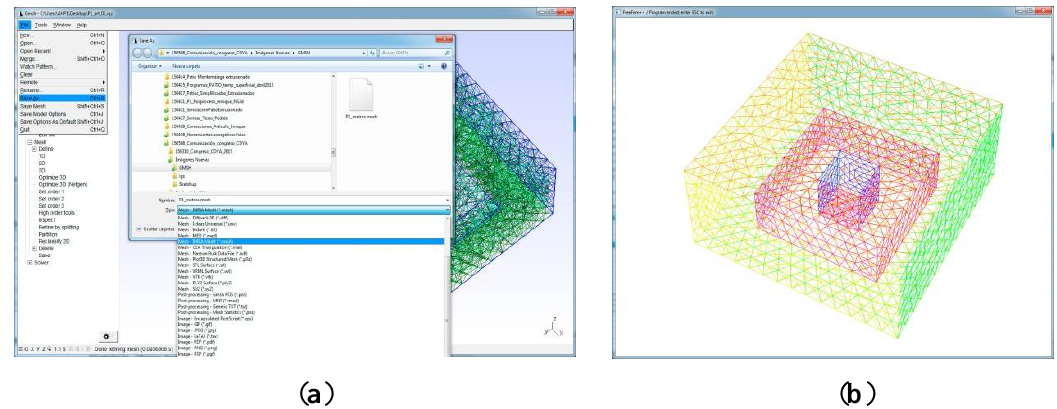
Figure 8. Mesh made in GMESH and imported in FreeFem++ with geometry constructed in SketchUp, a and b process steps. ( a ): importing process from GMESH, ( b ): result in FreeFem++